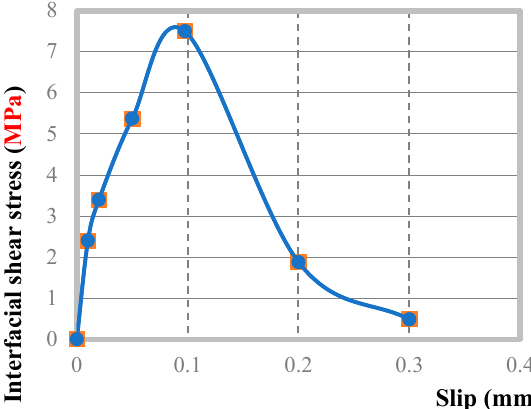
Figure 9. Geometry of INTER205 interface element.